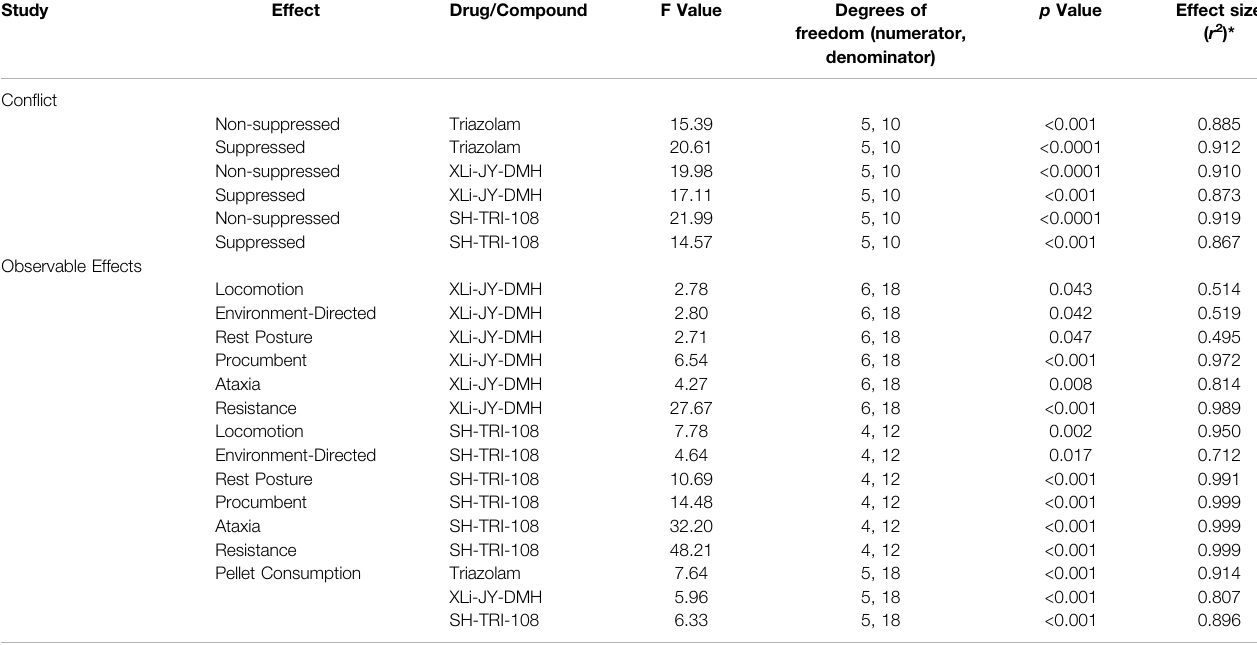
TABLE 5 | Summary of omnibus tests of signi fi cance (repeated measures analyses of variance) for the behavioral experiments with triazolobenzodiazepines.